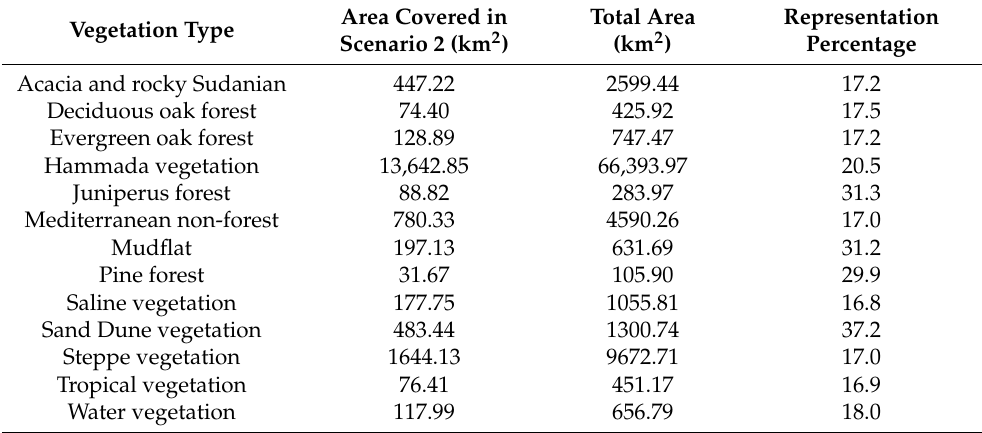
Table 7. The area and representation areas and percentage of each vegetation type in solution for scenario